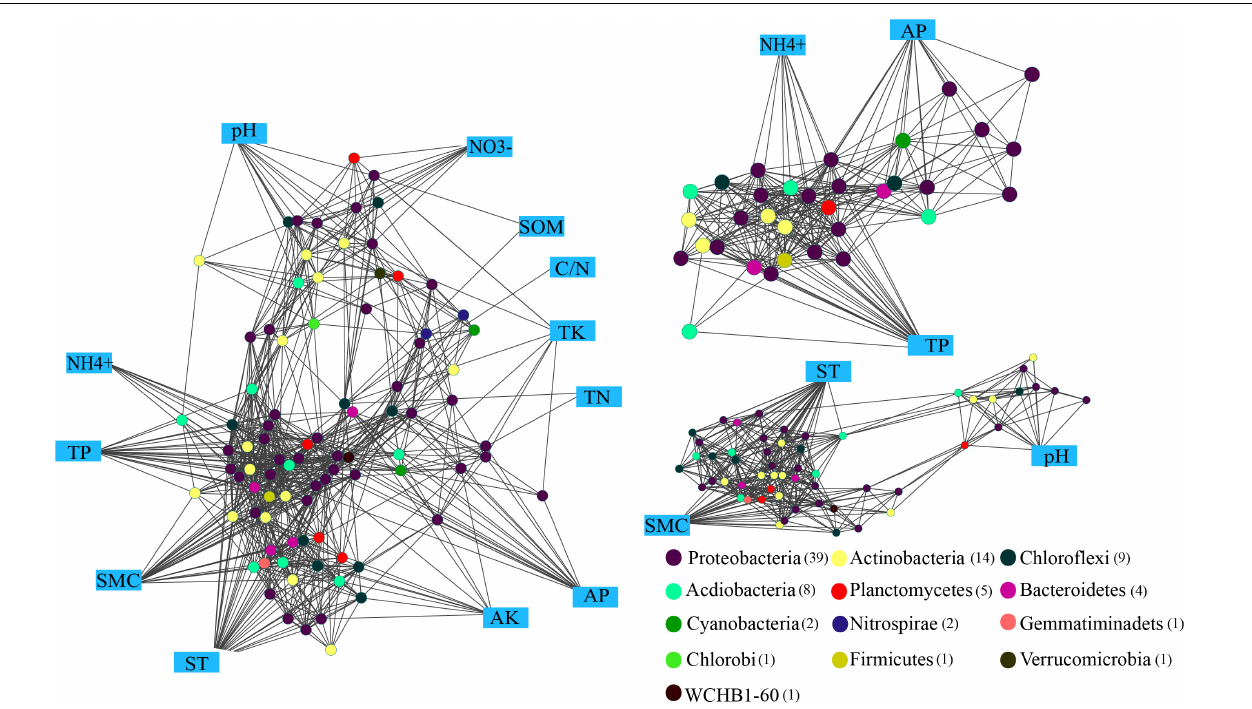
FIGURE 6 | Network analysis showing the connectedness between the bacterial communities and edaphic factors in P . tabulaeformis forest located on Qinling Mountains. A connection stands for a strong (Spearman’s ρ > 0.6) and significant ( P < 0.01) linear relationship. Variables in blue boxes represent various edaphic properties. The maximum connectedness, exhibited on the associations between the edaphic properties (AP, TP, and NH 4 + ) and soil microclimate (ST and SMC) as well as soil pH, are shown separately.